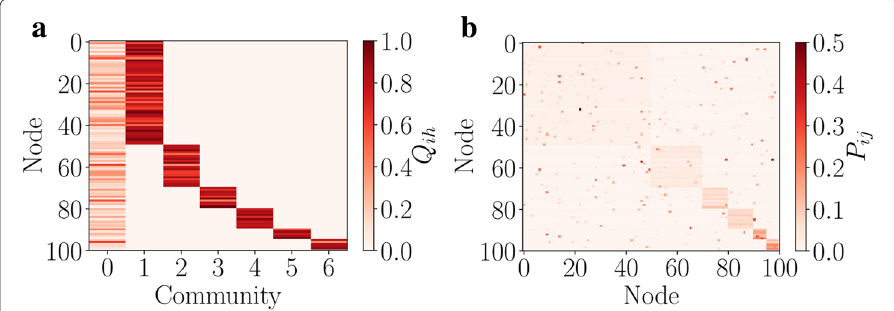
Fig. 5 Matrices characterizing the benchmark with exclusive communities. In ( a ), the community strength matrix Q is represented, while ( b ) shows the resulting routing matrix P . The values of the entries of the matrices are represented by the corresponding color